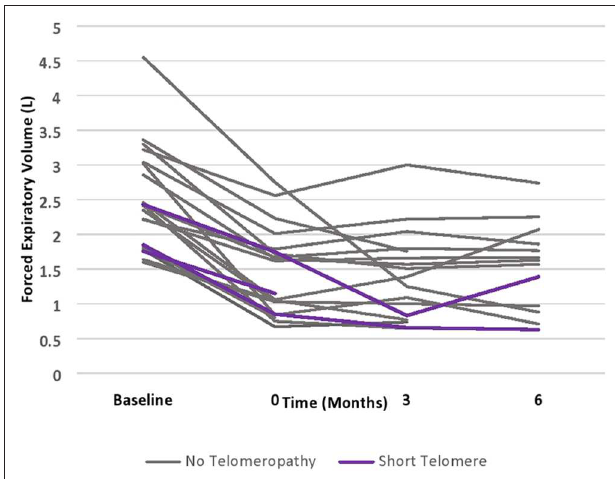
FIGURE 1 | Allograft function in patients after receiving Alemtuzumab.